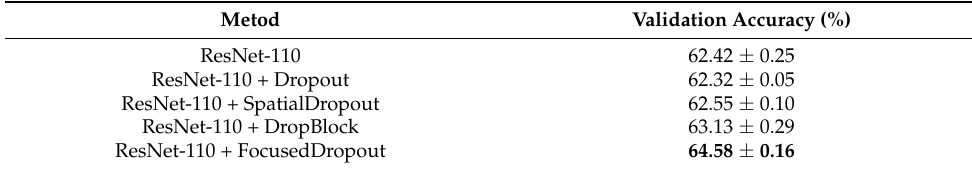
Table 3. The performance comparison on Tiny ImageNet dataset. The best accuracy is achieved by FocusedDropout. We report the average over 3 runs.